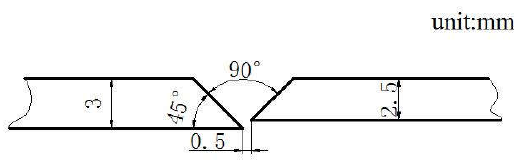
Figure 1. Welding configuration of dissimilar joints.